Question: Condense the content of this figure into a single sentence.
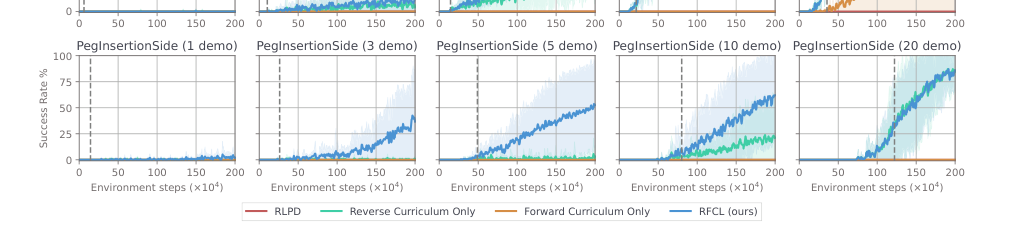
Answer: Mean success rate of algorithms on ManiSkill2 tasks after 2M interaction steps given varying amount of demonstrations to train on. Error bars represent 95% CIs over 5 seeds. Vertical gray lines indicate the average number of samples until the reverse curriculum completes. Reverse curriculum only is RFCL but instead of a forward curriculum in stage 2 we sample uniformally from the initial state distribution. Forward curriculum only skips stage 1 training entirely. lum. Fig. 4 shows a selection of the most difficult tasks and demonstrate that RFCL is significantly better if the task is complex and difficult to explore. To visually see why these are more difficult see Appendix B.2. For a disambiguation of each environment’s results, see Appendix A.1.